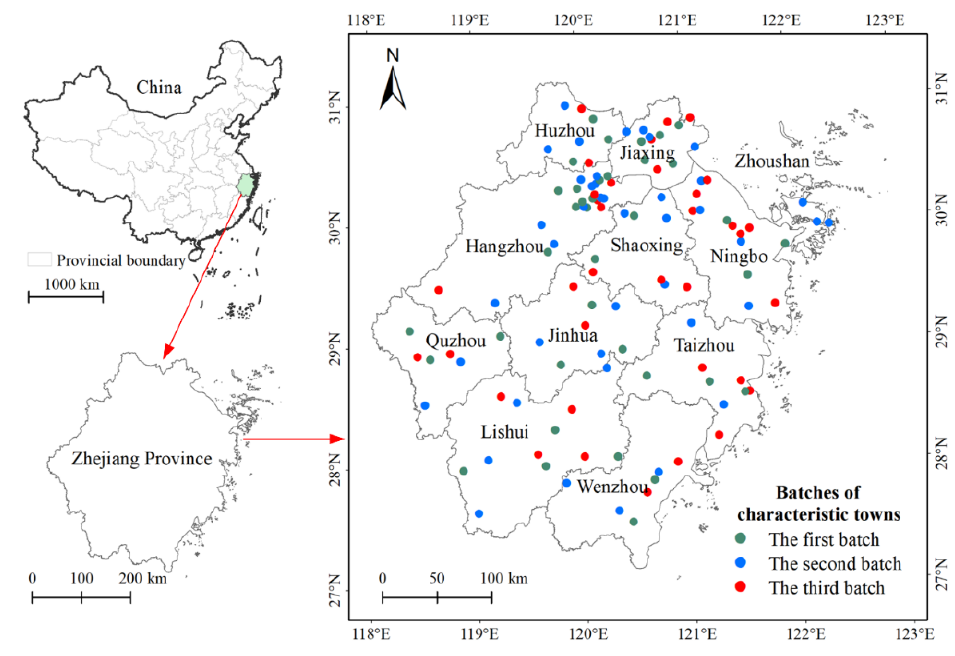
Figure 1. Study area.